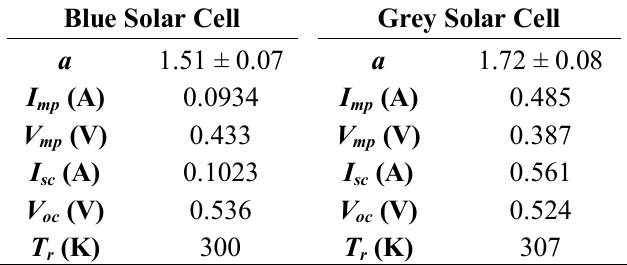
Table 1. Characteristic of blue solar cells and grey solar cells [17].